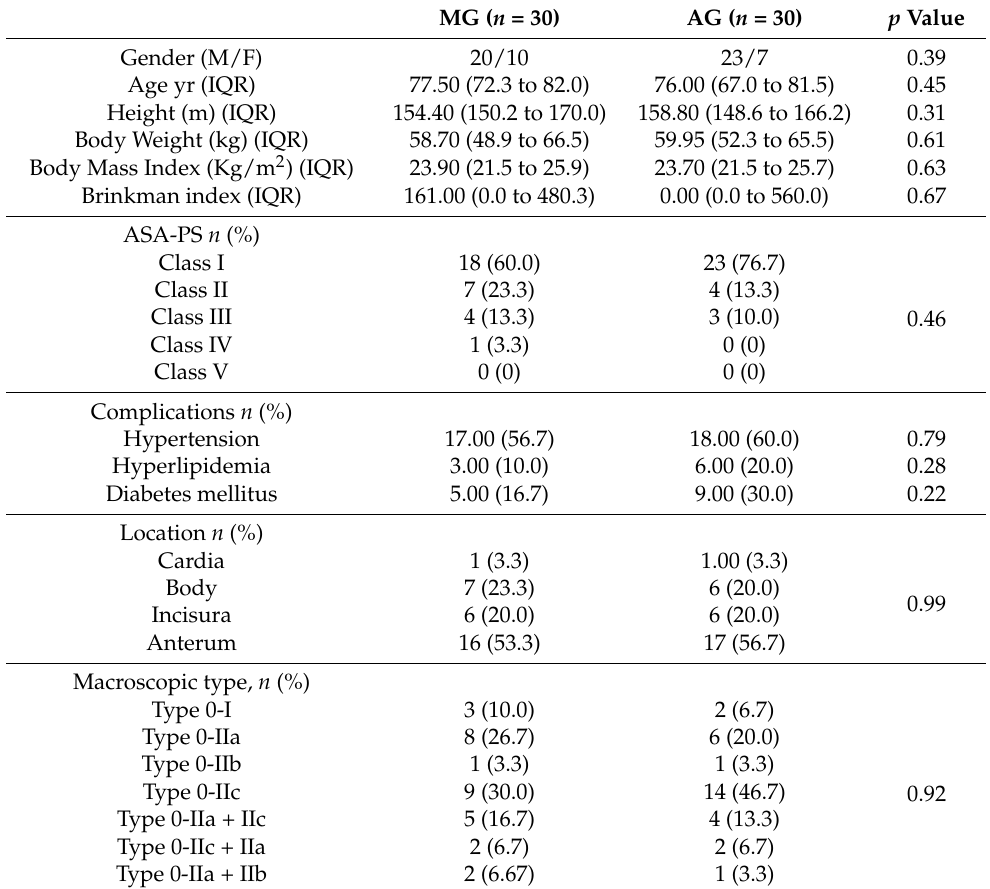
Table 2. Baseline subject characteristics.